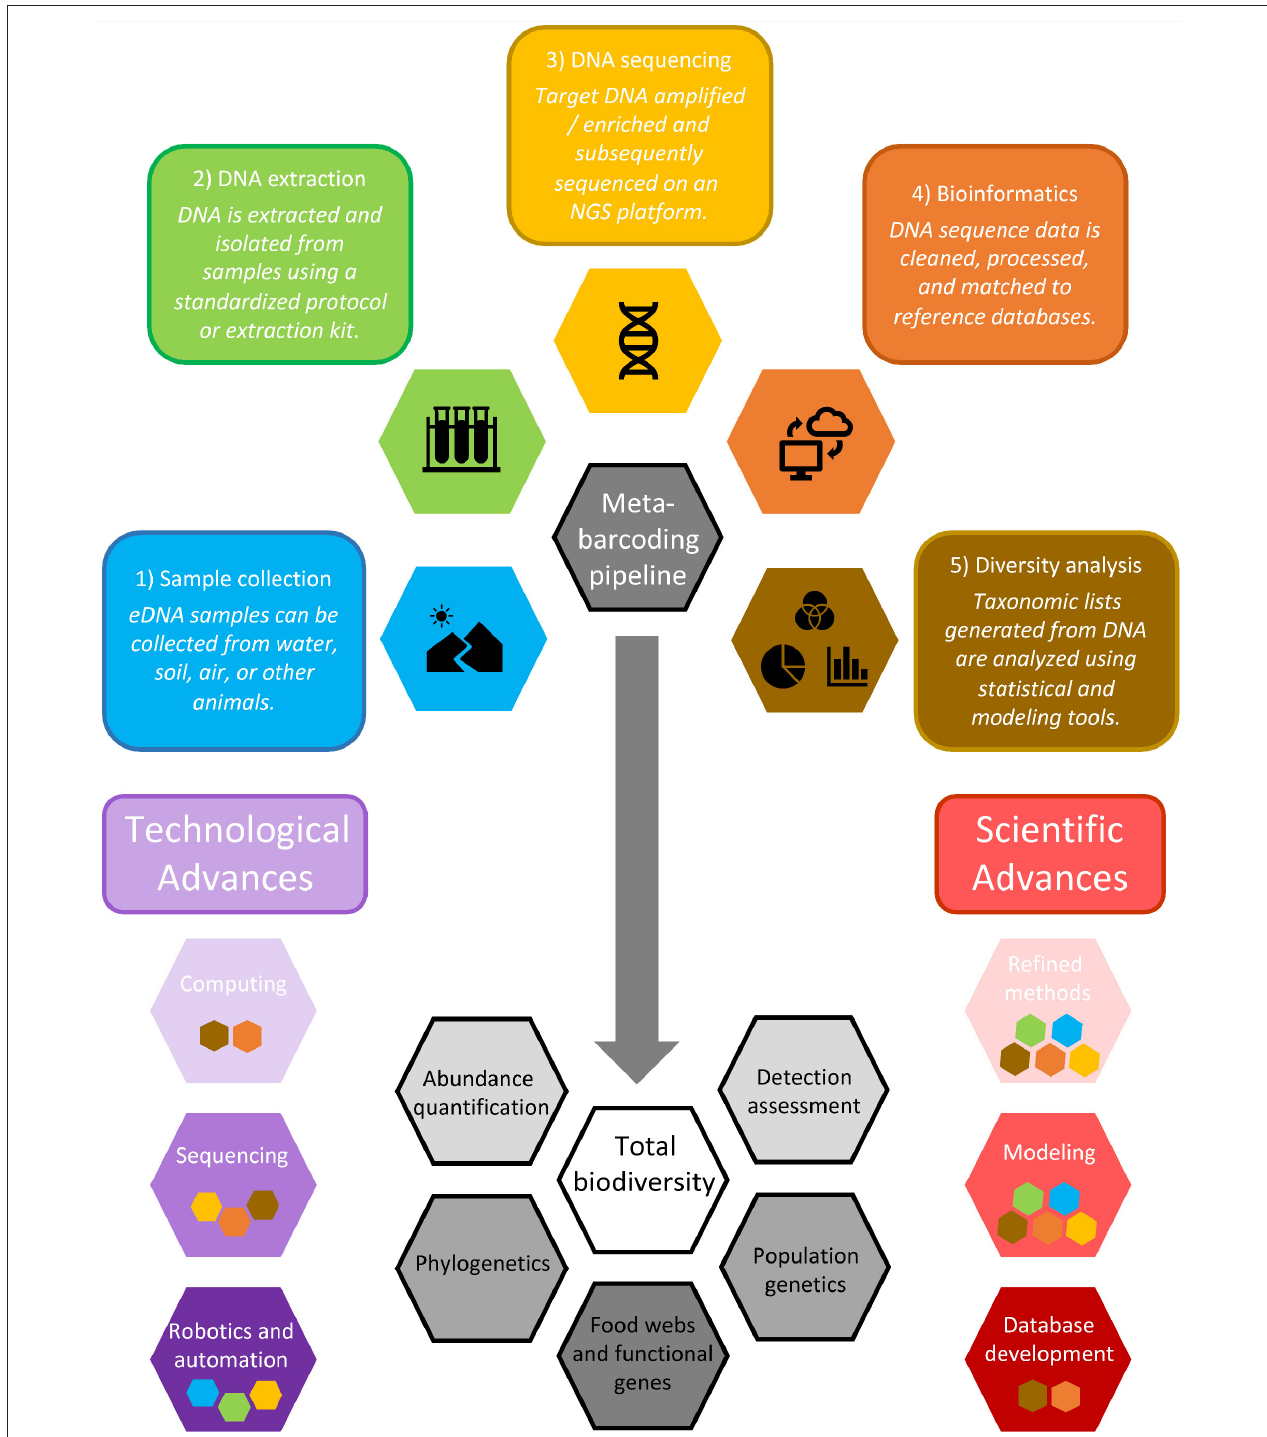
FIGURE 3 | Conceptual model outlining the DNA metabarcoding pipeline, including (1) sample collection, (2) DNA isolation and extraction, (3) high throughput sequencing, (4) bioinformatics, and (5) biodiversity analysis. Purple and red hexagons depict technological and scientific advances that will improve this workflow, with inset colored symbols reflecting the steps of the pipeline that will most benefit from these advances. The gray arrow indicates progress toward total biodiversity assessment (white) and other related advances (gray). Shape shading depicts advances and applications that range from those that are currently receiving a lot of attention and are achievable in the short term (light colors) to those that will require more research and development to achieve in the long-term (dark colors).